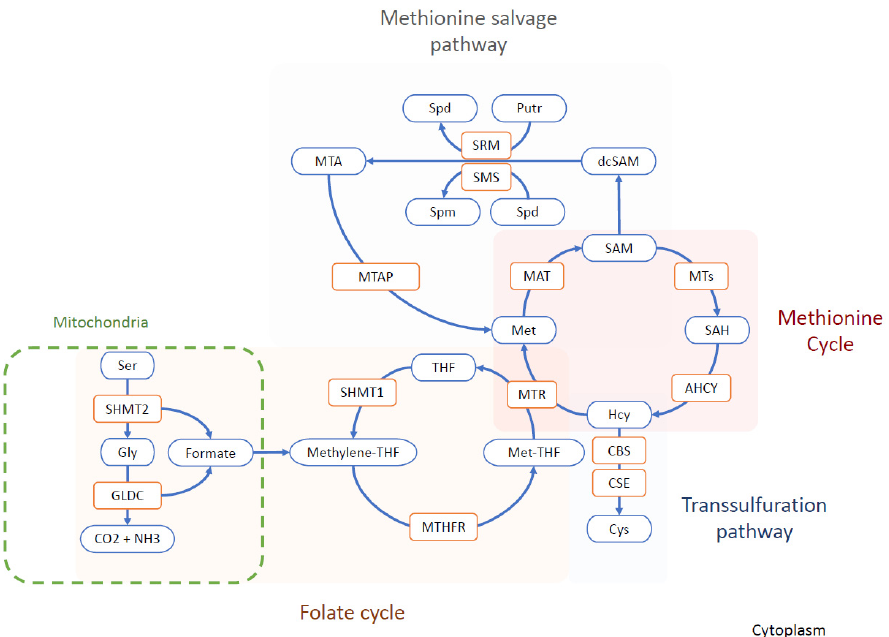
Figure 1. Simplified chart of the one-carbon metabolism. In the methionine cycle, methionine is converted into SAM via MAT. SAM is a universal methyl donor. SAM is converted to SAH in transmethylation reactions by methyltransferases. The resulting SAH is converted to homocysteine, which can either pass through the transsulfuration pathway, forming cystein in 2 steps catalyzed by CBS and CSE, or remethylated to methionine by MS, using the methyl group provided by Met-THF. The remethylation regenerates THF, which is then used to produce methylene-THF and Met-THF via SHMT1 and MTHFR, respectively. Methylene-THF can also be generated in the mitochondria by pathways that involve SHMT2 and GLDC. In the methionine salvage pathway, SAM decarboxylation produces an aminopropyl group donor for Putr and Spd synthesis. The donation of the aminopropyl group is catalyzed by aminopropyl transferases and produces MTA. MTA is converted back to SAM via MTAP. Abbreviations: AHCY, adenosylhomocysteinase; CBS, cystathionine beta synthase; CO2, carbon dioxide; CSE, cystathionine γ -lyase; Cys, cysteine; dcSAM, decarboxylated S-adenosylmethionine; GLDC, glycine decarboxylase; Gly, glycine; Hcy, homocysteine; MAT, methionine adenosyltransferase; methylene-THF, methylenetetrahydrofolate; Met-THF, methyltetrahydrofolate; MTA, methylthioadenosine; MTAP, methylthioadenosine phosphorylase; MTHFR, methylenetetrahydrofolate reductase; MTR, methionine synthase; MTs, methyltransferases;